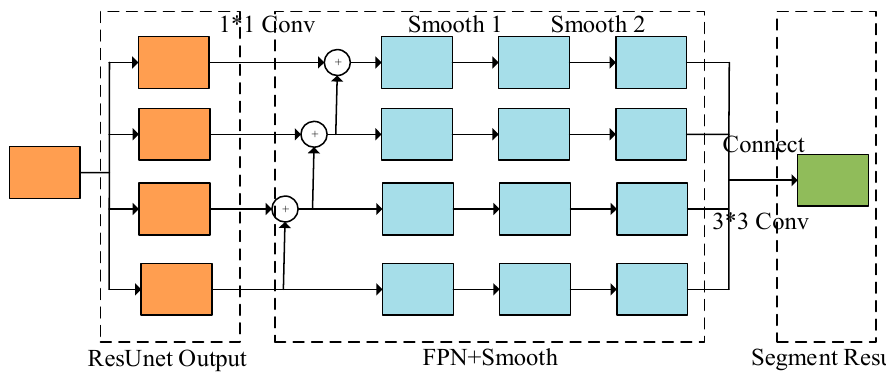
Figure 6. The structure of the local branch of GL-HRNet.